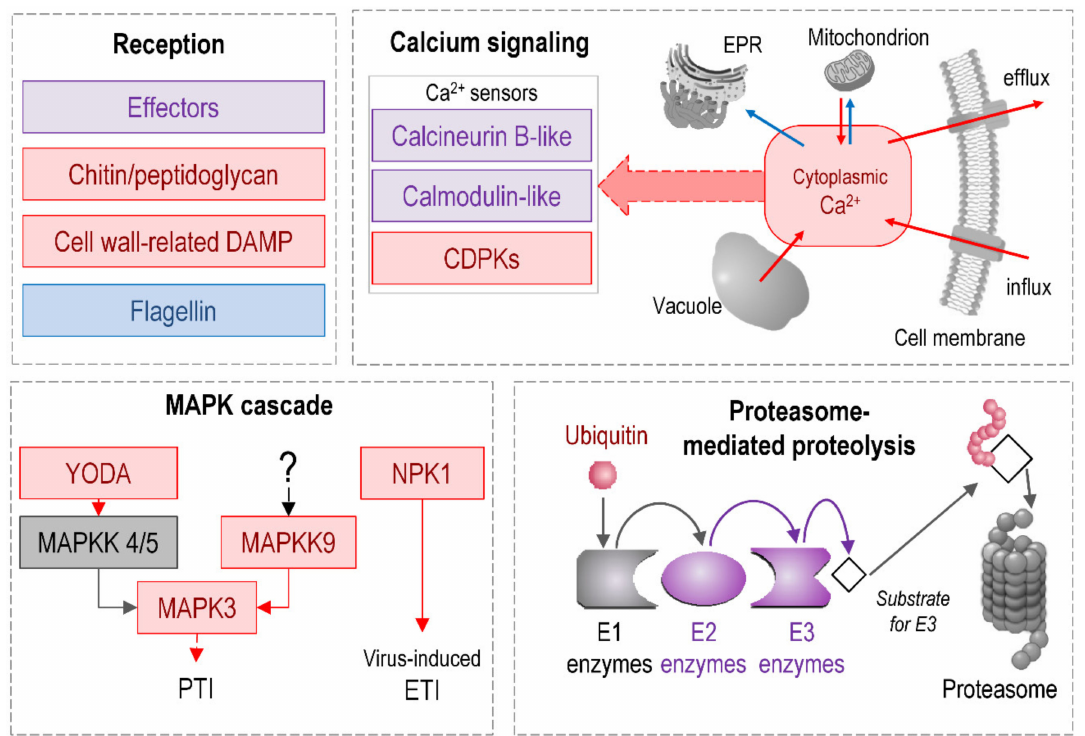
Figure 7. Regulation of genes related to signal perception and transmission in tobacco plants infected by P. atrosepticum . Signaling-related proteins encoded by mostly upregulated, mostly downregulated, non-DEGs, and both up- and downregulated DEGs are marked in red, blue, gray, and purple, respectively. The scheme was assembled based mostly on KEGG reference pathways as well as the SwissProt database and sources of literature cited in the